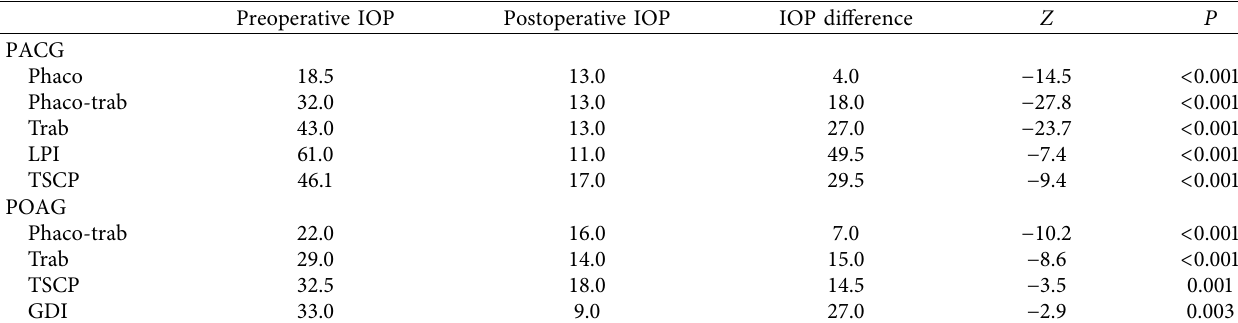
Table 4: Changes in IOP after different surgical methods for primary glaucoma (M, mmHg).